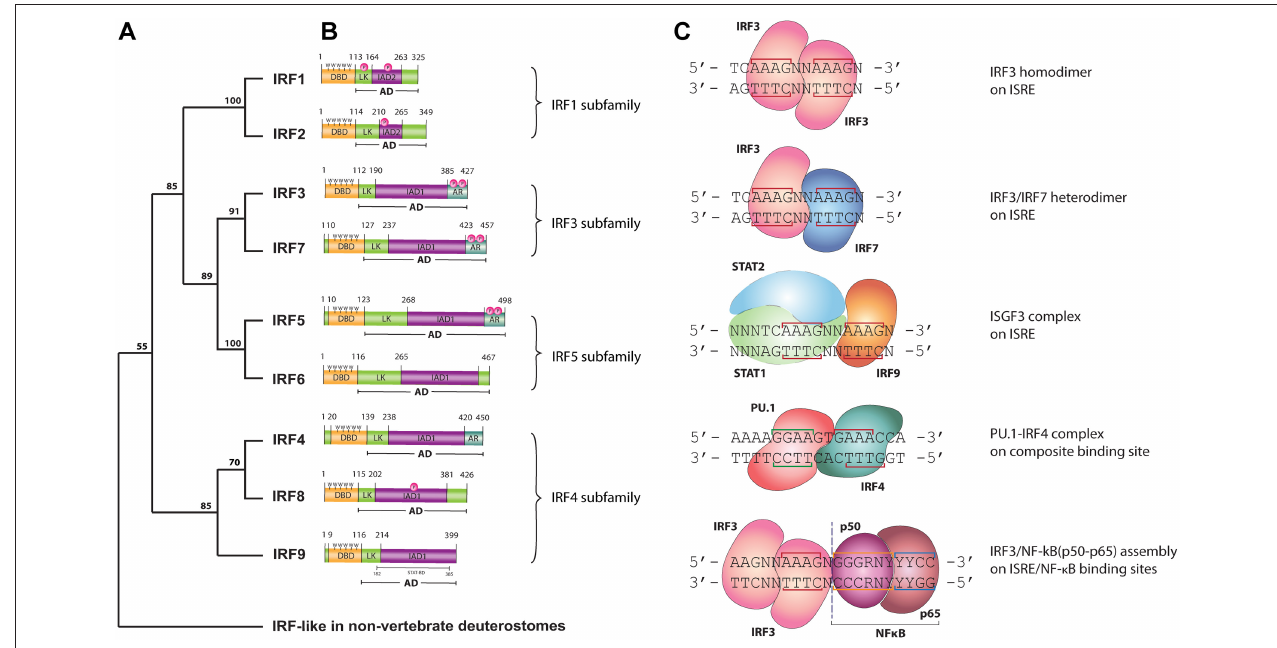
FIGURE 1 | (A) Phylogenetic tree of the DNA-binding domain of IRF family proteins in vertebrates. Homologous protein sequences were searched using the NCBI BLAST server and aligned using ClustalW. Phylogenetic analyses were performed using the Neighbor-Joining method within the Mega 7.0 program. Data were analyzed using Poisson correction, and gaps were removed by pairwise deletion. The bootstrap values of the branches were obtained by testing the tree 10,000 times. Bootstrap values larger than 70% are shown next to the branches based on 10,000 replications. (B) Functional domains of human IRF proteins. DBD, DNA-binding domain; AD, activation domain; LK, linker region; IAD, IRF association domain type 1 (IAD1) or type 2 (IAD2); AR, auto-inhibitory region; P, phosphorylation site; 5W, five tryptophan repeats—“tryptophan cluster”; STAT-BD, STAT-binding domain. (C) DNA binding modes of IRFs. LINE—nucleotides involved in interaction with IRF—DBD; N, any nucleotide; R, purine; Y, pyrimidine. IRF3 homodimer, IRF3/IRF7 heterodimer and ISGF3 are bound to the consensus ISRE sequence with two ISRE half-sited “GAAA.” IRF4/PU.1 complex bind to the composite binding site, while NF- κ B binds κ B DNA element. ( Figure 1C ). The DNA-binding specificity and affinity differences of these complexes collectively shape the transcriptional activity of